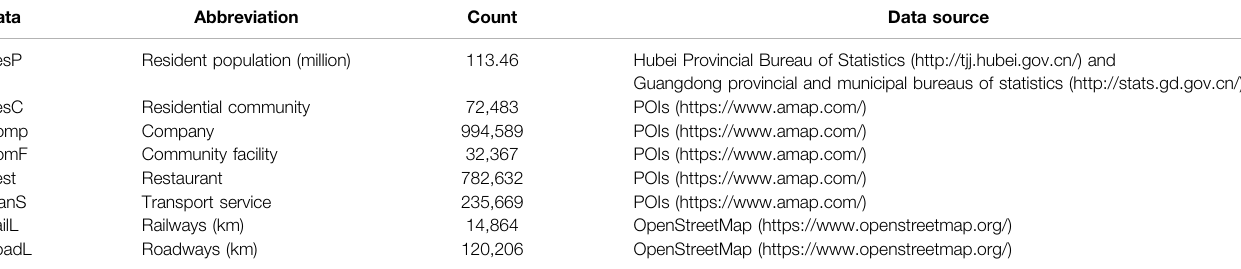
TABLE 1 | Abbreviations of the socioeconomic data used in this